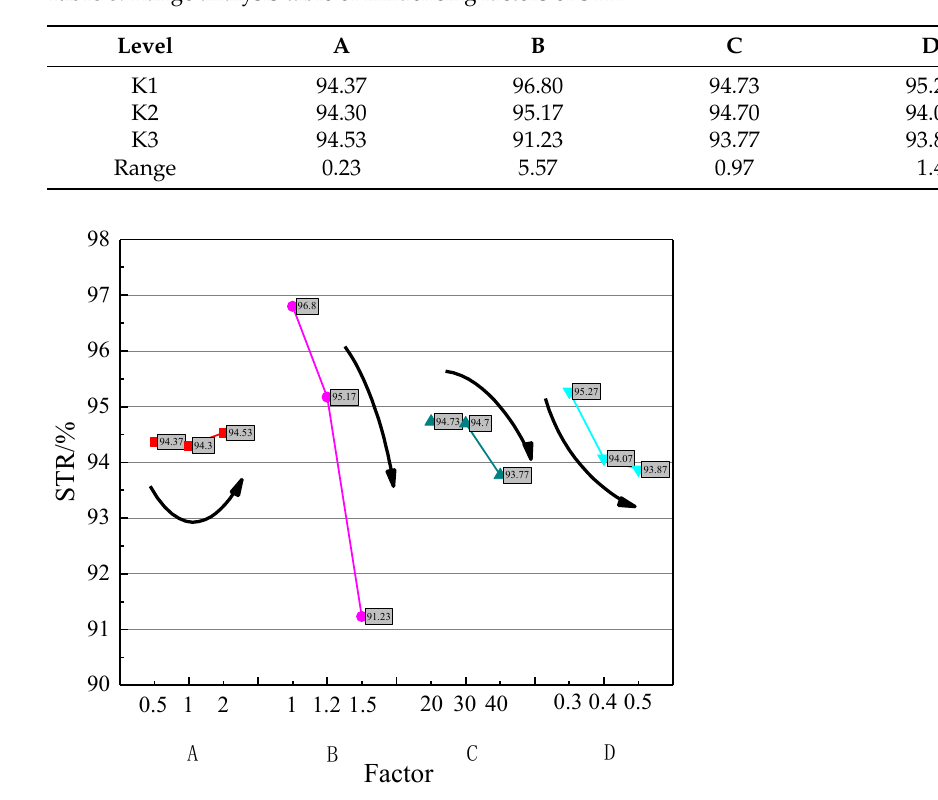
Table 8. Range analysis table of influencing factors of STR.